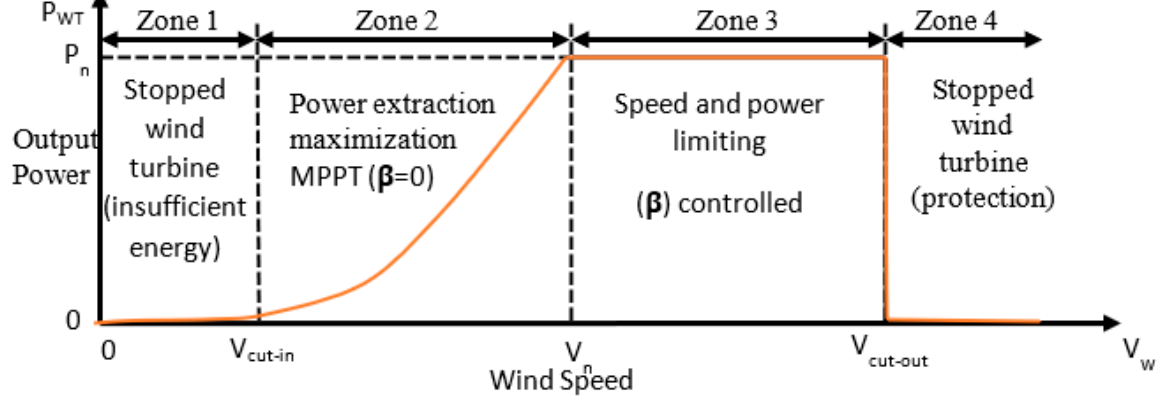
Figure 2. Different operation zones of a wind turbine.